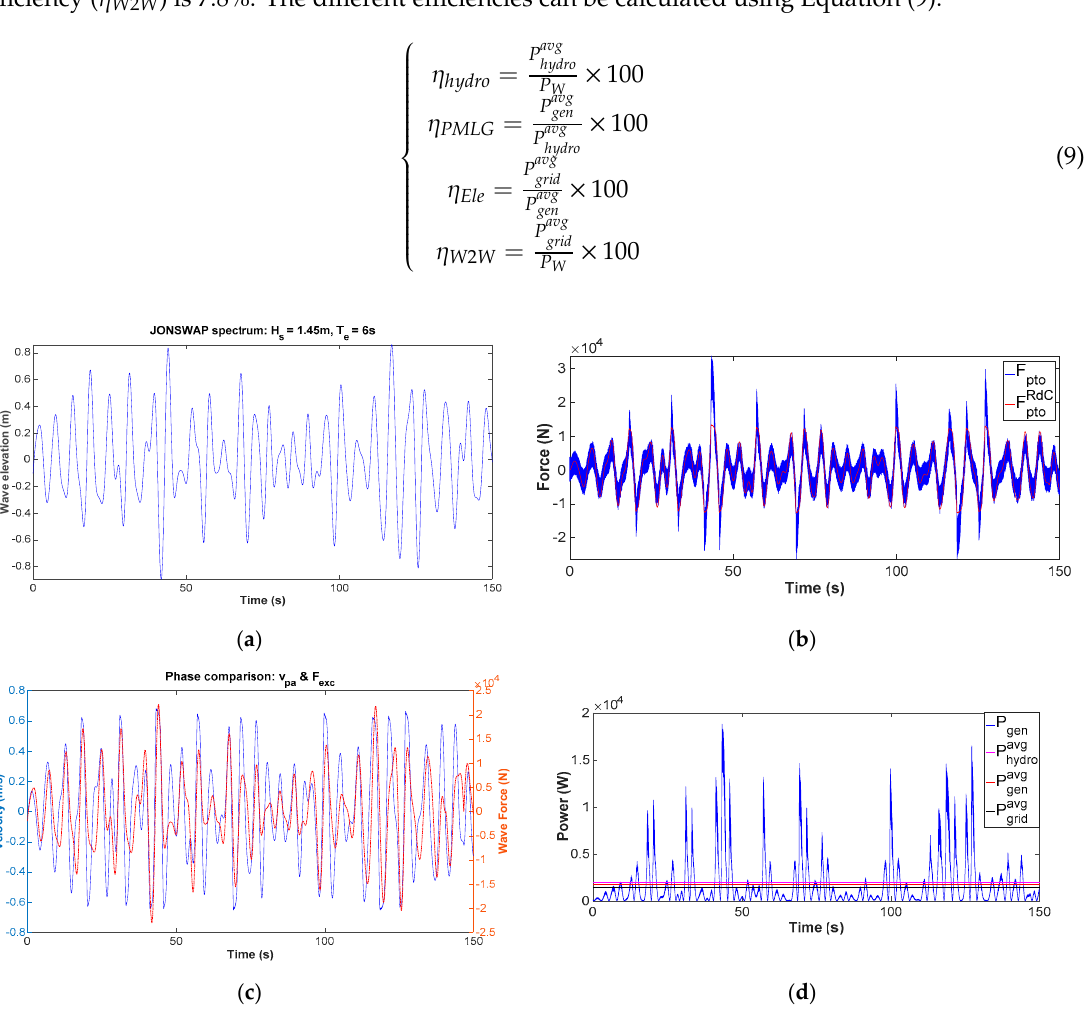
Figure 8. Simulation results using the RdC method: ( a ) Wave resource used as input; ( b ) Reference and actual PTO force; ( c ) Phase comparison between the velocity and wave excitation force; ( d ) Instantaneous generator power and average hydrodynamic, generator and grid power.